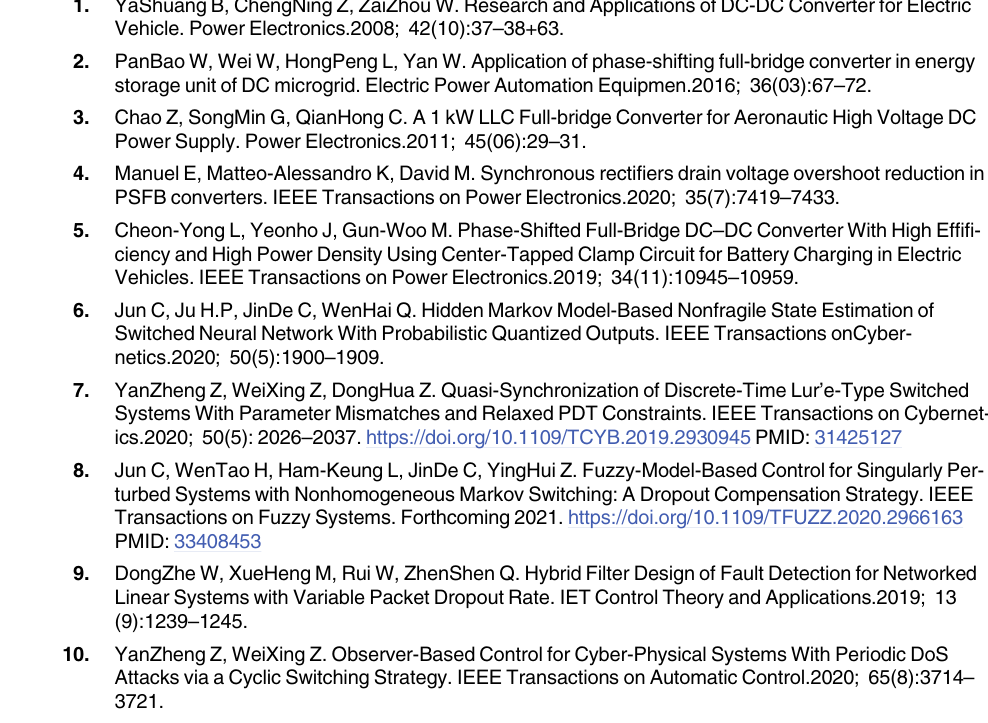
in MATLAB/Simulink. eq